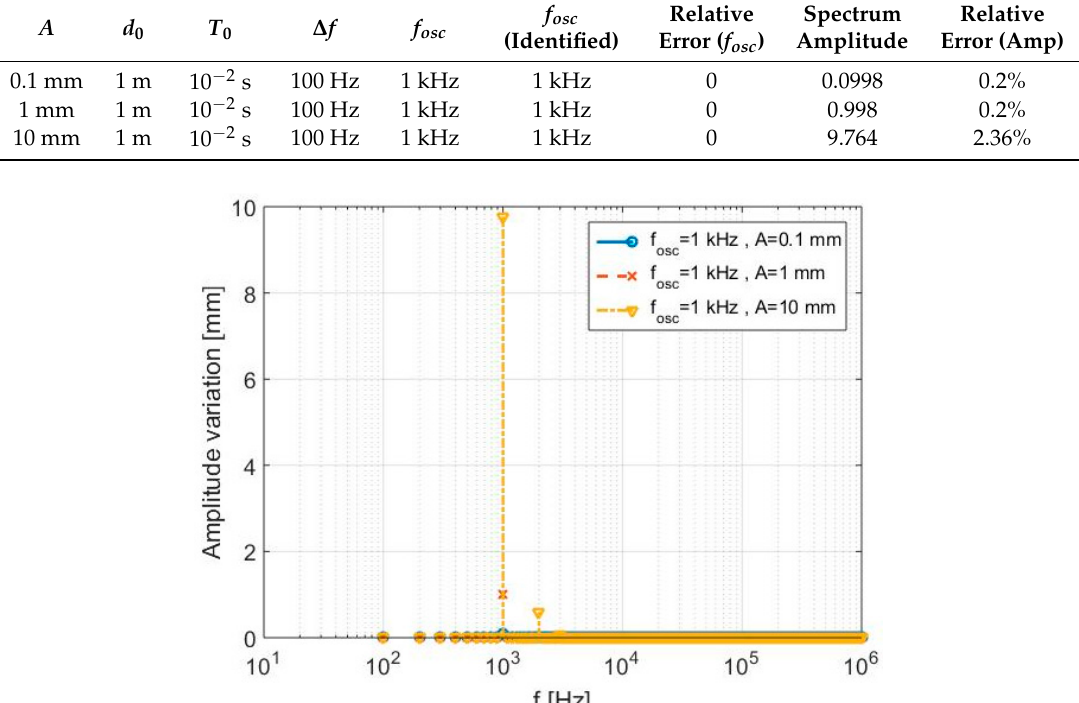
Table 3. Second simulation—Parameters and results.